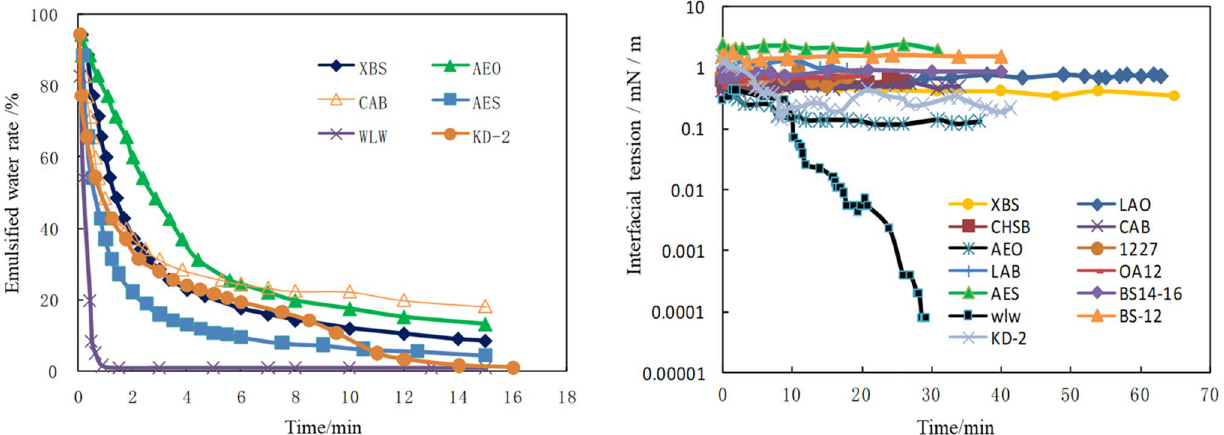
Fig. 2 IFT (left) and emulsification test results (right) of different surfactants